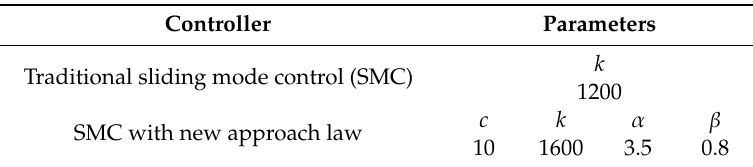
Table 3. Controller